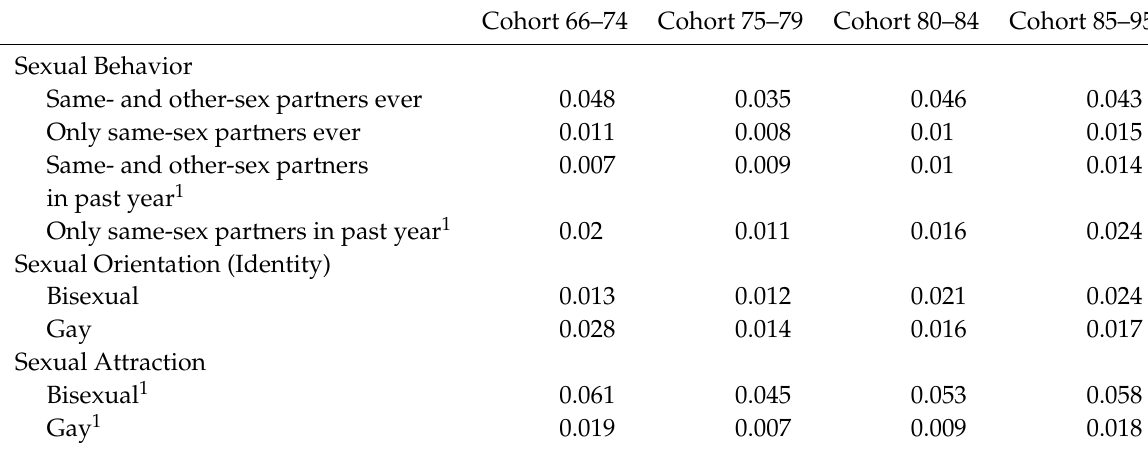
Table 5: Men’s predicted